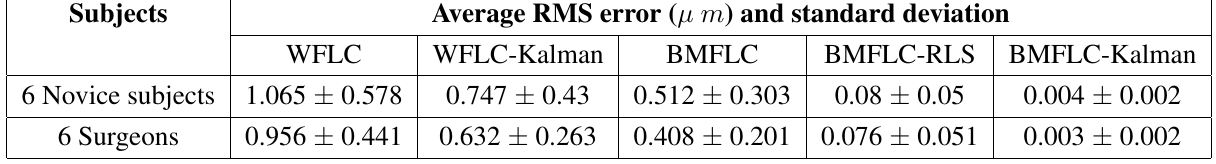
Table 1. Average RMS error on all trails for tremor estimation